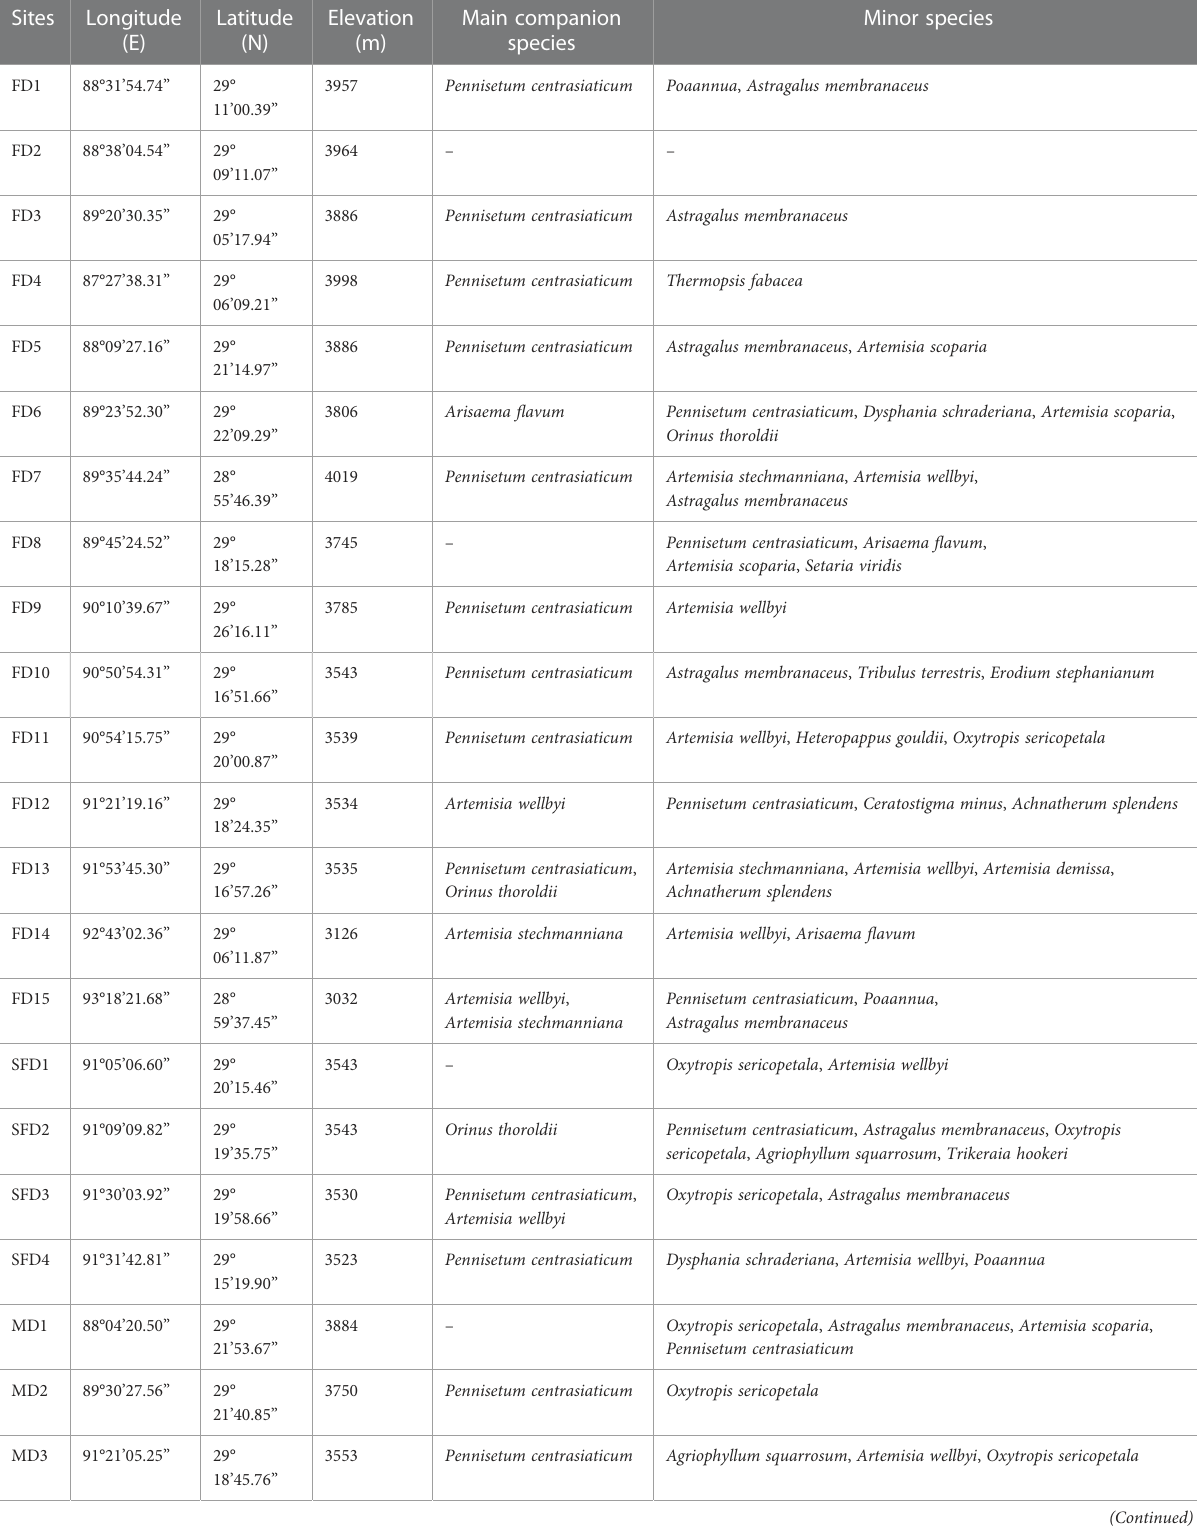
TABLE 1 Main geographic characteristics and fl oristic compositions of the S.moorcroftiana shrubs sampling sites among the middle reaches of the Yarlung Zangbo River basin.